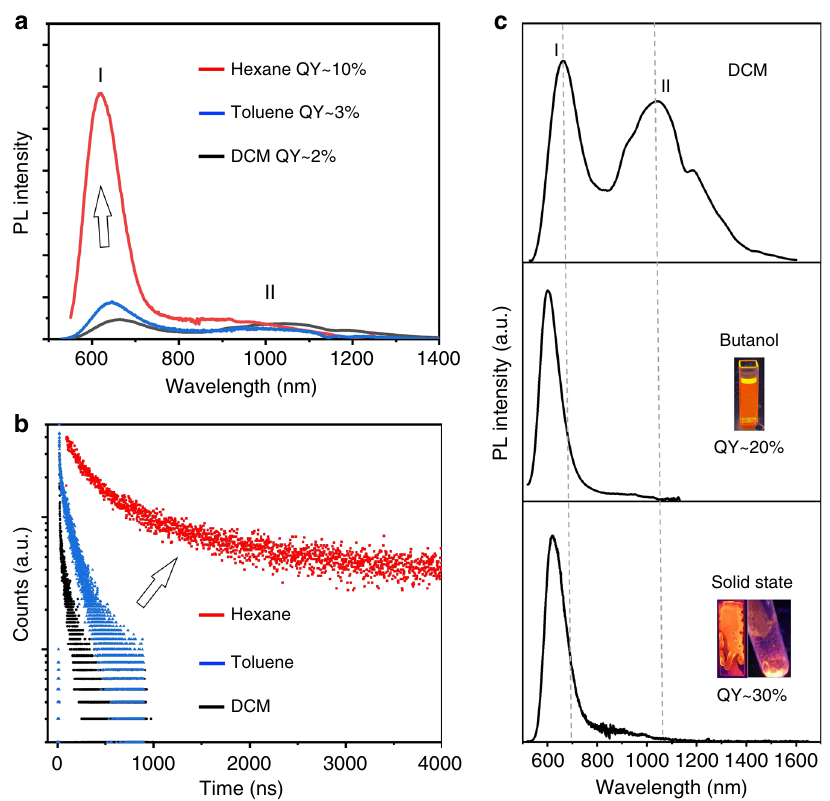
Fig. 3 Solvent polarity and viscosity dependence, as well as the solid-state PL of Au 24 . Comparison of the PL ( a ) and TCSPC ( b ) of Au 24 in DCM (black), toluene (blue) and hexane (red). TCSPC trajectories were detected from 550 to 650 nm. c Comparison of the PL of Au 24 in DCM (top), butanol (middle), and solid state (crystal or fi lm, bottom). From top to bottom, the overall QY of Au 24 increases from 2% to 30%, which is accompanied by an increase in the ratio of PL I/PL II and the blue shift of the PL I. Inset photographs: Au 24 in butanol and solid-state fi lm and single crystals under UV lamp. QY quantum